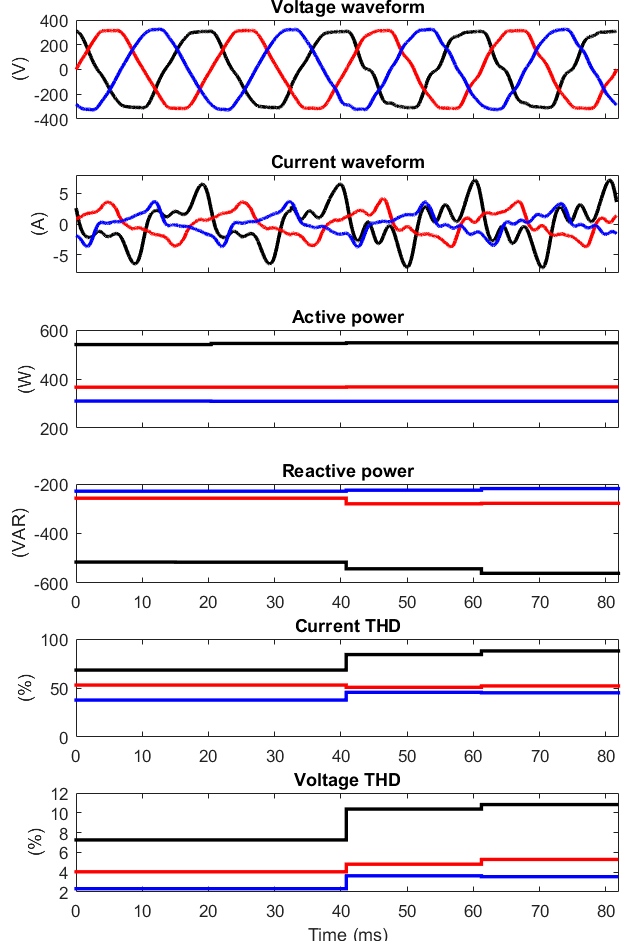
Figure 4. Example of an occasion when the voltage THD increases in the evening. The voltage waveform is at the top followed by the current waveform, active power, reactive power, current THD and voltage THD. The black, red and blue color represents the three phases.